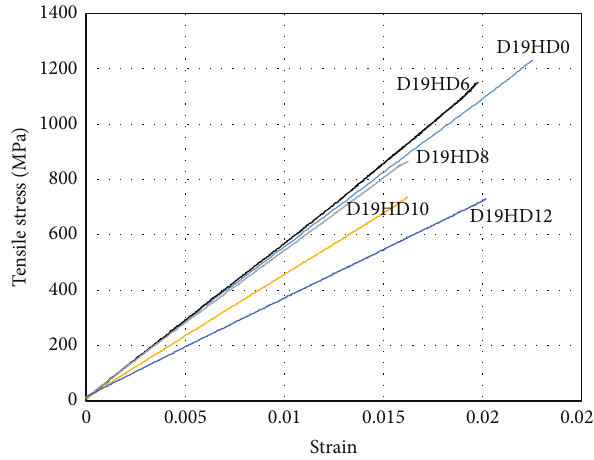
Figure 9: Stress-strain curve sample of GFRP rebar specimens.